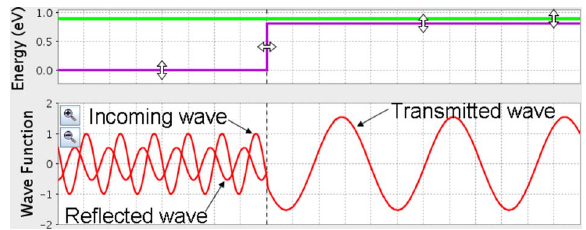
FIG. 12. (cid:1) Color (cid:2) A case where the amplitude of the transmitted wave is higher than the amplitude of the